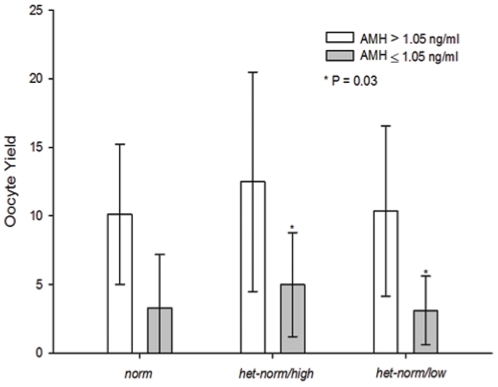
Oocyte yields in association with FMR1 genotypes and sub-genotypes.Here presented data exclude 20 cancelled cycles, and, therefore, represent 23 het norm/high and 33 het-norm/low women for statistical comparison. Including 9 cancelled cycles in these two sub-genotypes, the comparison maintains significance (P = 0.03). It also maintains significance using the independent samples Mann-Whitney U test (data not shown).